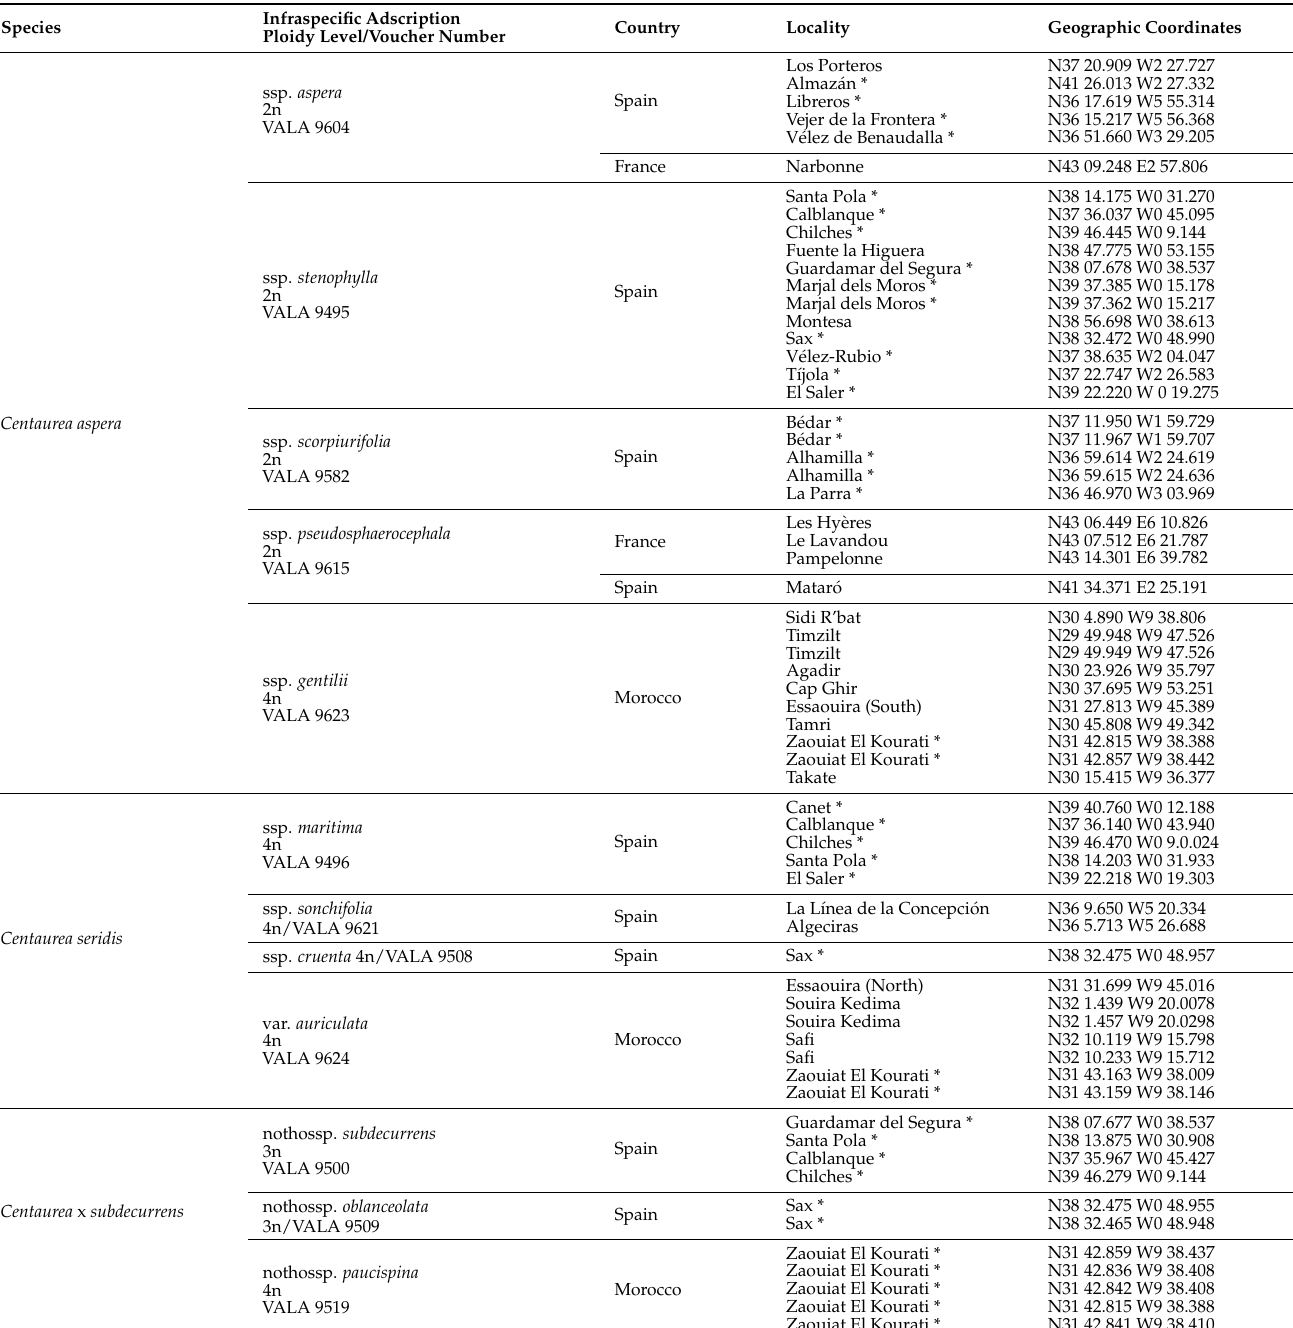
Table 4. Taxonomic adscription, location, and voucher number if available for all the studied Centaurea individuals. * Individuals that have already been morphologically characterized, their ploidy level analysed and taxonomically adscribed